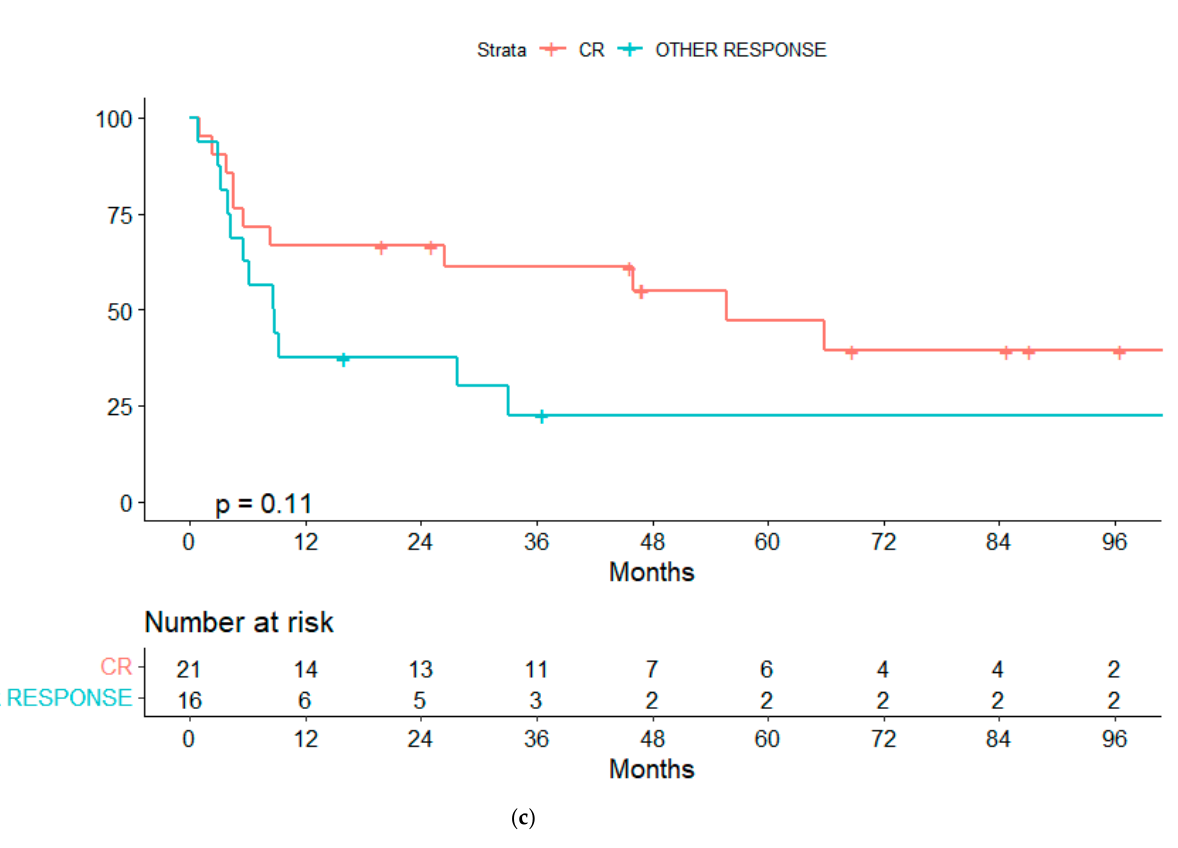
Figure 2. ( a ) Overall survival (OS) for reduced-intensity conditioning (RIC) and myeloablative conditioning (MAC) regimens. ( b ) OS according to chronic graft-vs-host disease (cGVHD). ( c ) OS according to lymphoma status pre-alloSCT, complete response (CR) or other response.